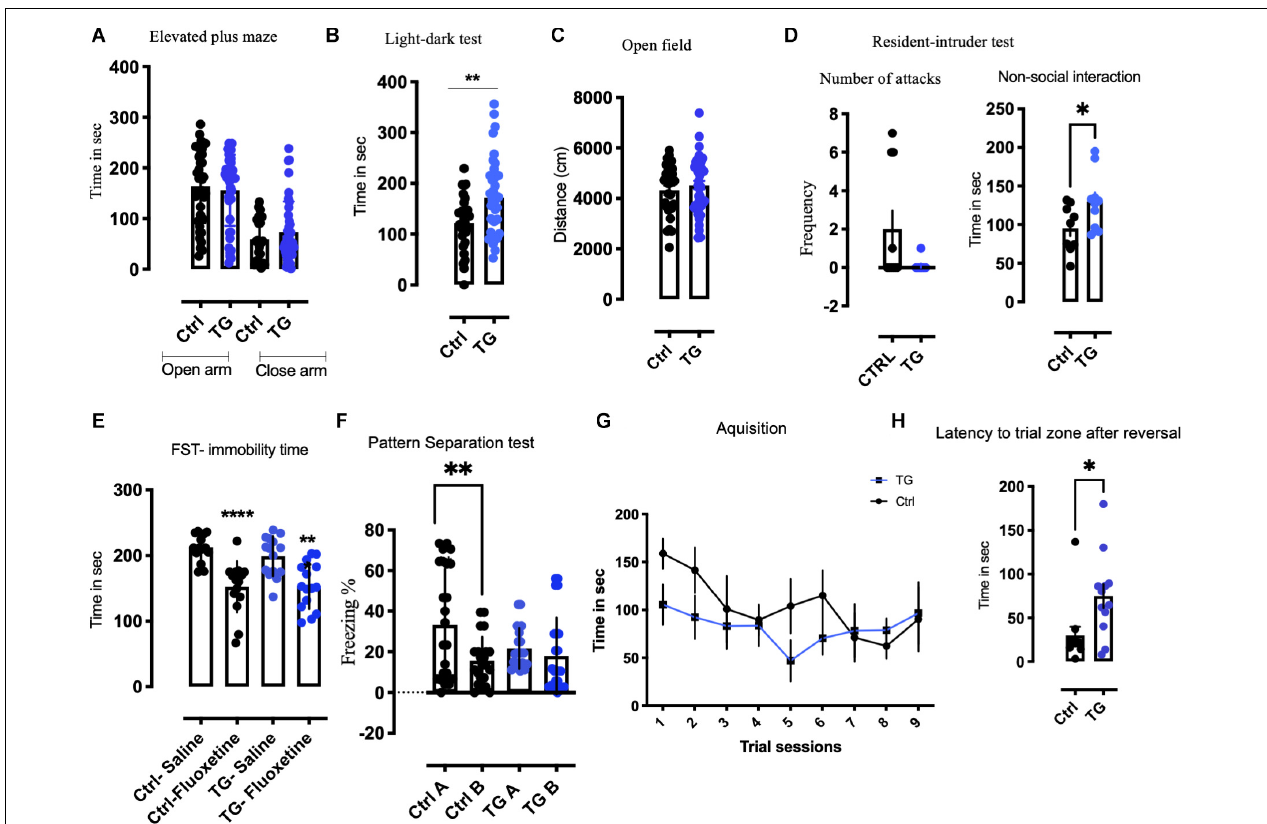
FIGURE 3 | Transgenic animals displayed anxiolytic like, non-aggressive interaction, altered pattern separation, and reversal learning in a battery of behavioral tests. (A) In the Elevated plus maze (EPM), no significant change was observed in the time spent in open or closed arm in both the groups ( N = 30/group). (B) In the light-dark test (LD), time spent in the light by the TG animals was significantly higher than controls ( N = 30/group). (C) In the open field (OF), the total distance traveled remained unchanged between the groups ( N = 30/group). (D) In resident intruder test (RI), number of attacks was unaffected between the genotypes, whereas significant non-social behavior was observed. The TG animals showed non-social defensive behavior compared with the controls ( N = 12/group). (E) The Immobility time was reduced after acute fluoxetine in both genotypes subjected to forced swim test (FST). (F) In Pattern separation experiment paradigm (PS), the control animals exhibit pattern completion distinguishing context A from context B after 10 days of continuous exposure to both the context. The TG animals contextual pattern separation is inhibited ( N = 20/group). (G) In Barnes maze test (BM), both the animals learned during acquisition. (H) The latency to target zone during reversal training was significantly increased in the TG animals. Student’s t -test, Two-way ANOVA, * p -value < 0.01, ** p -value < 0.001, and **** p -value < 0.0001. Error bars represent Means ±